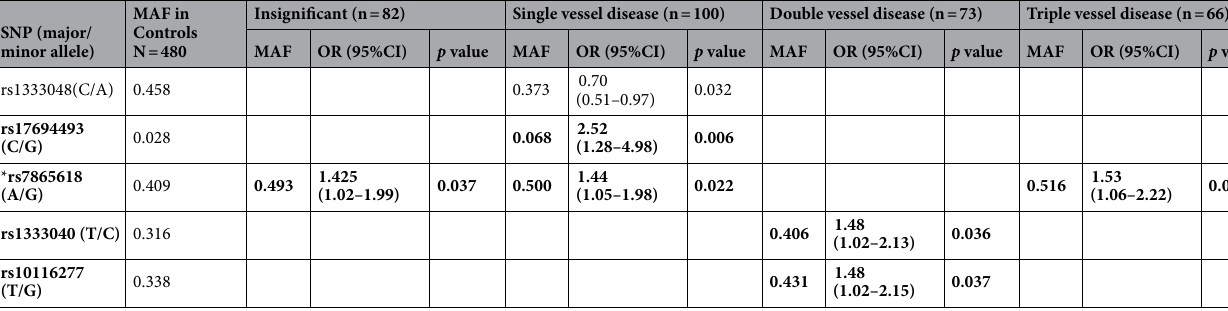
Table 3. Association of variants at 9p21.3 chromosomal region with anatomical categories of CAD. *Significantly associated in the sample of pooled CAD cases. Bold indicates the details of significant risk confering SNPs.